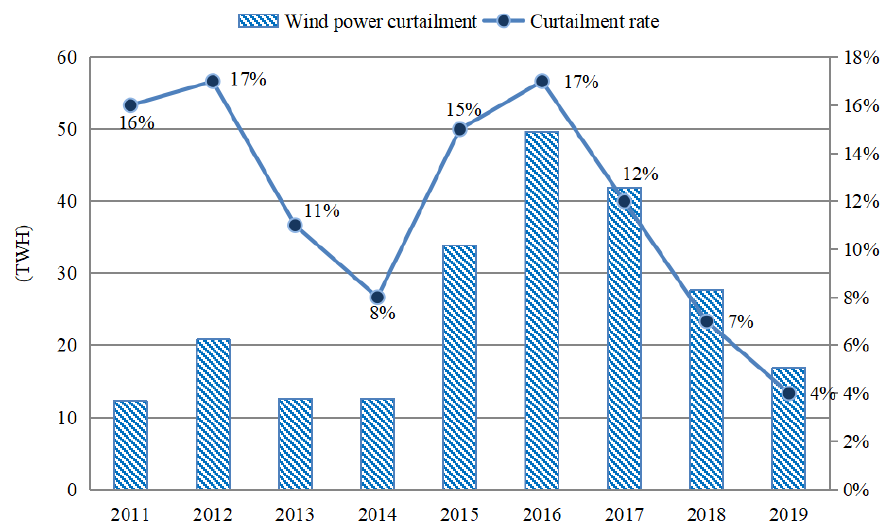
Figure 13. Statistics of China’s wind power curtailment in 2011–